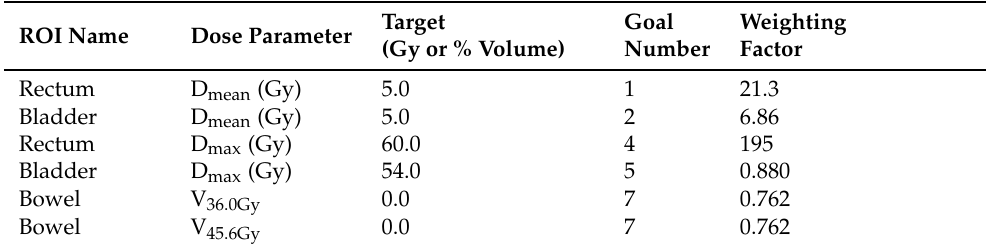
Table 3. Priority 3—Trade-off Goals (Standard). Target represents dose in Gy (i.e., D mean and D max ) or percentage of ROI volume (i.e., V 36.0Gy and V 45.6Gy ). Targets are automatically adjusted during optimisation (via the PBAIO algorithms) to ensure PGs are minimised. Therefore initial values have negligible influence on the final plan, but may decrease planning time if correctly defined.